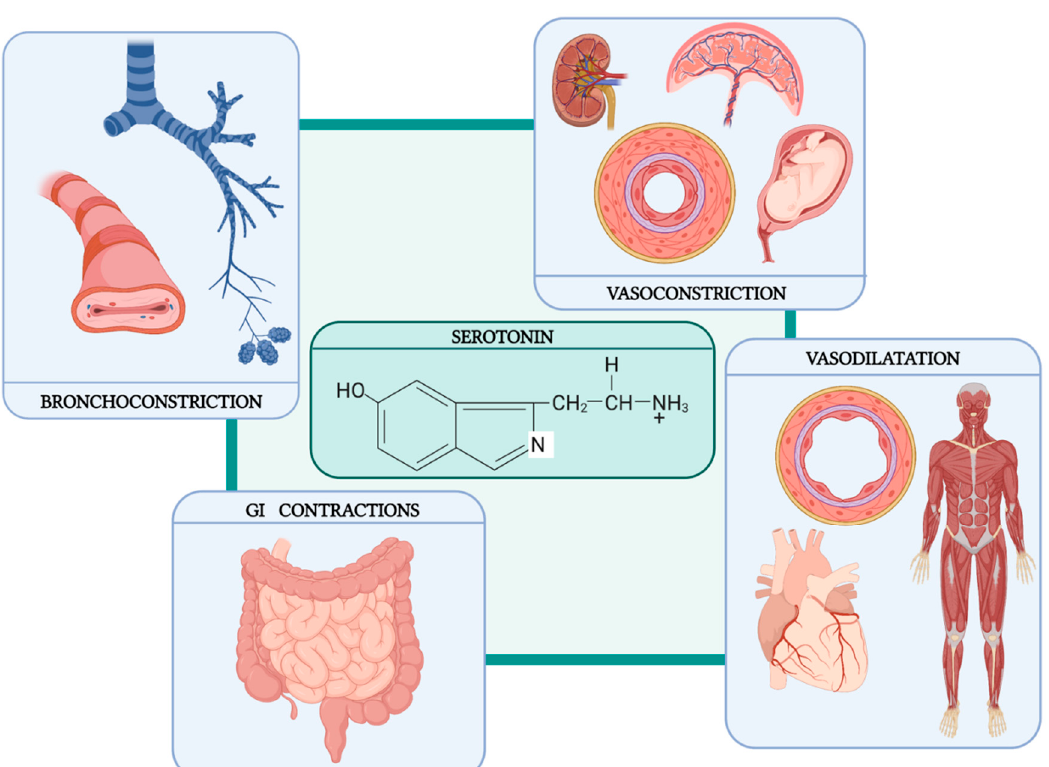
Figure 2. Peripheral effects of serotonin.